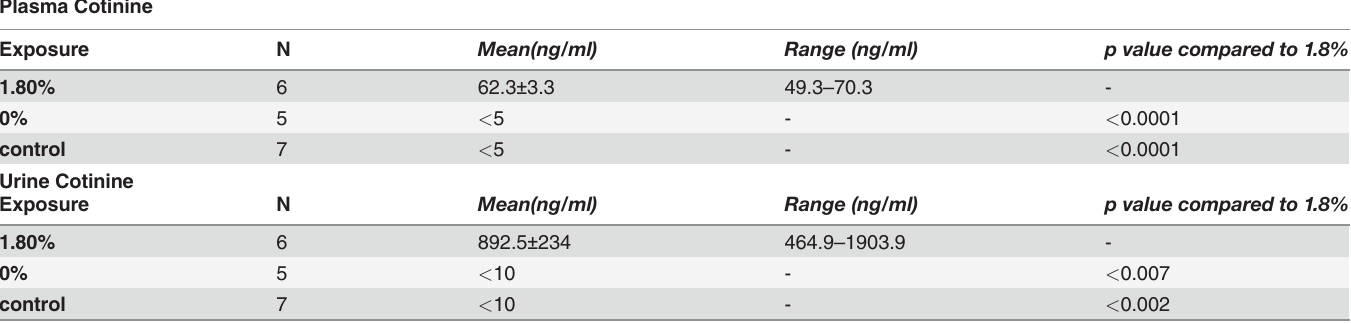
Table 1. Plasma and urine cotinine levels in 10 day old mice. Plasma